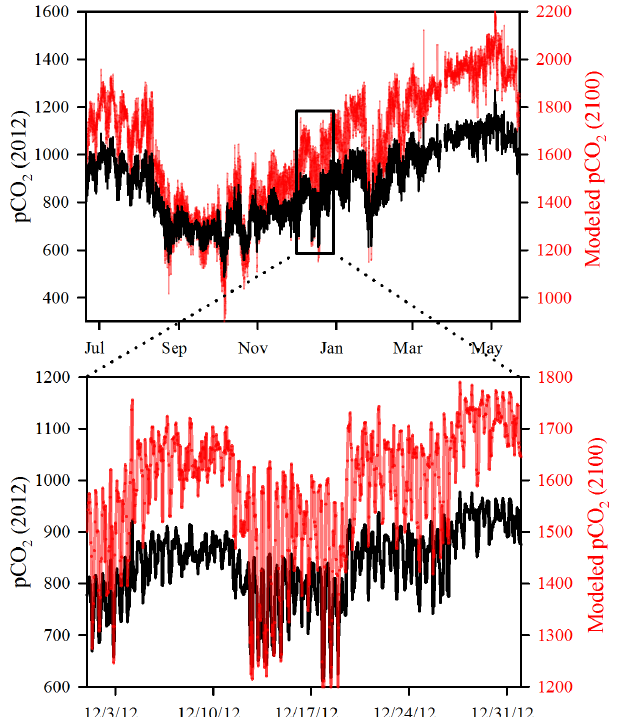
Figure 9. Observed (cid:127) Ar in 2012 (black) and modeled (cid:127) Ar us- ing the IPCC RCP6.0 scenario for the year 2100 (red) at the shelf break (88m) over an annual cycle (top). A close-up for the month of December is shown in the bottom panel. Dashed lines represent (cid:127) Ar = 1. Note that the range, but not the absolute values, of the vertical axes for each figure is the